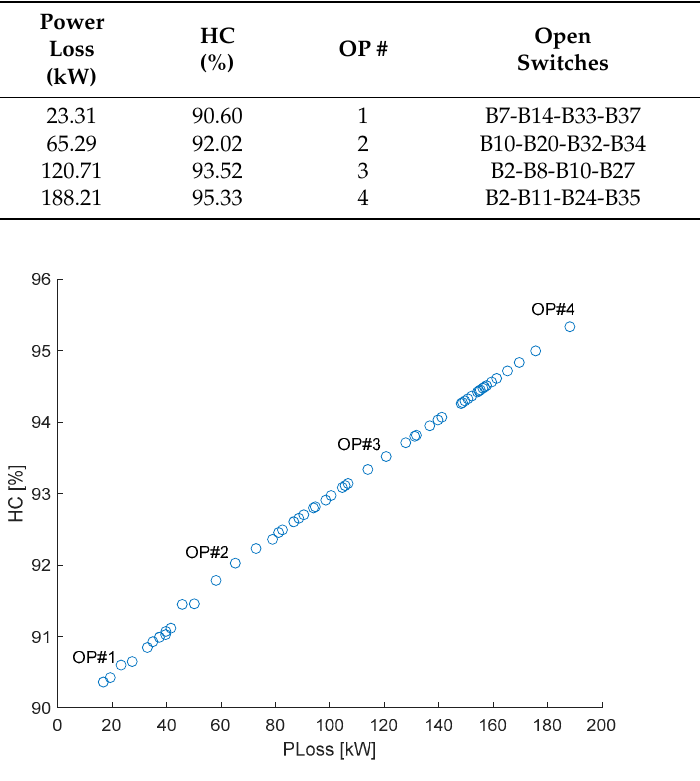
Figure 16. Pareto front for comparison with [14].